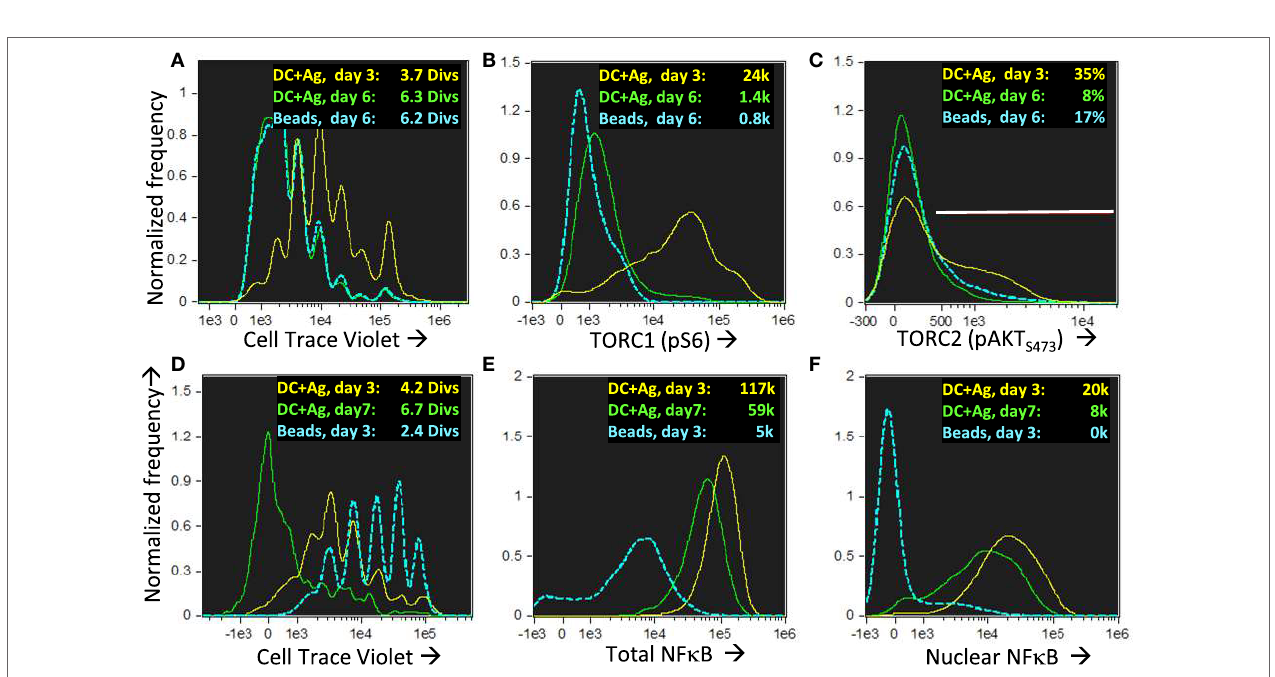
FigUre 13 | Nuclear NFkB is maintained in long-lived memory cells without uropodia even when they reach quiescence and mTOR activation has ceased. Cell trace violet (CTV) labeled female A1RAG CD4 + T cells were stimulated for 3 or 6 days in the presence of IL-2, TGF β , and ATRA with bone marrow-derived